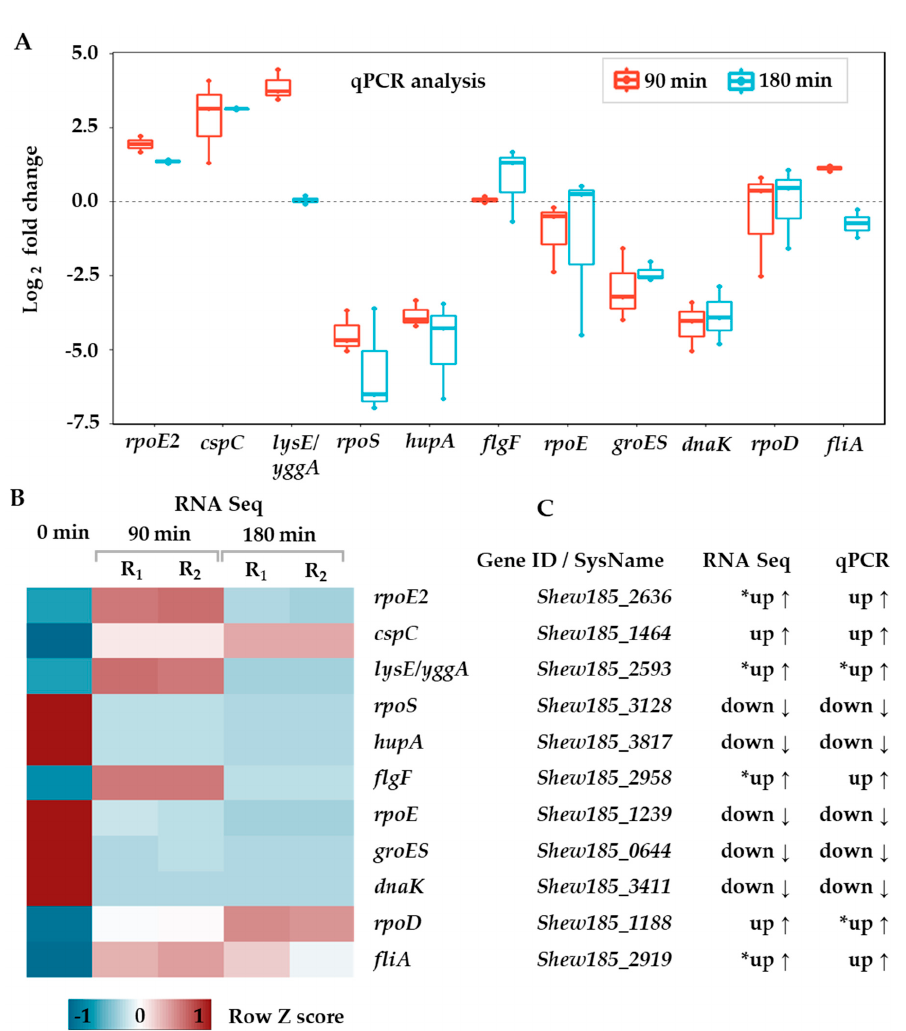
Figure 2. Validation of RNA sequencing results with RT-qPCR. ( A ) Log 2 fold change of relative gene expression measured by RT-qPCR. Data were normalized to three reference genes (for details see the Materials and methods, Section 3.4). Each point represents average of four technical repeats for a biological replicate. Red and blue colors mark 90 and 180 min time points, respectively. ( B ) Heatmap showing row Z-score transformed, row scaled expression for corresponding genes. Column 0 stands for control sample for 0 min time point; replicates for 90 and 180 min time points are labeled R 1 and R 2 . ( C ) Direction of changes in respect to control (time 0) for corresponding RNA-seq and RT-qPCR assays. Asterisk (*) marks the expression change categorized as up although in fact it is upregulated only after 90 min while downregulated after 180